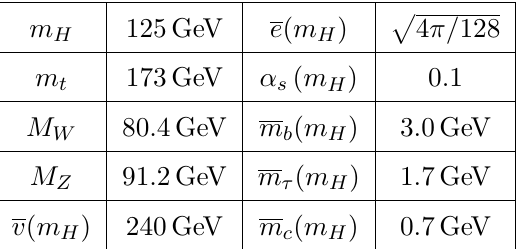
Table 1 . Input parameters used in numerics. The derived quantity v ( m H ) = 2 M W ˆ s w /e ( m H ) is listed for